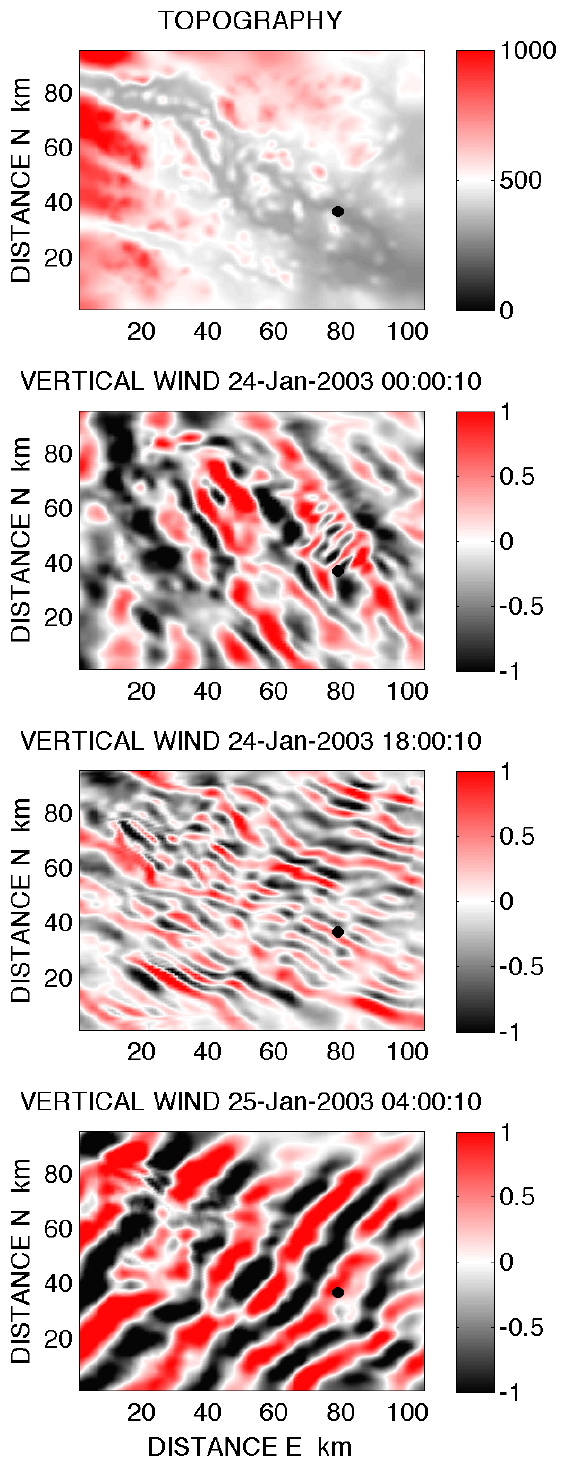
Fig. 7. Plan views of the topography and of the mountain waves, at 3 different times, in the WRF model innermost domain, for the model level which is at 3000m height above the radar site. Vertical wind is in